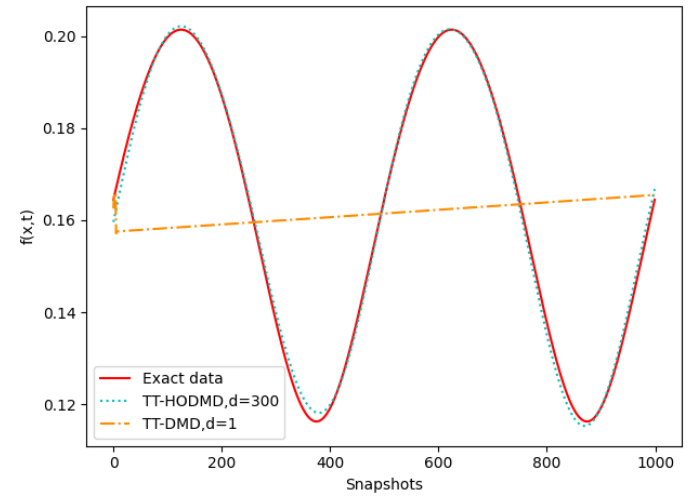
Figure 3. Comparison of TT-DMD ( d = 1 ) and TT-HODMD ( d = 300 )